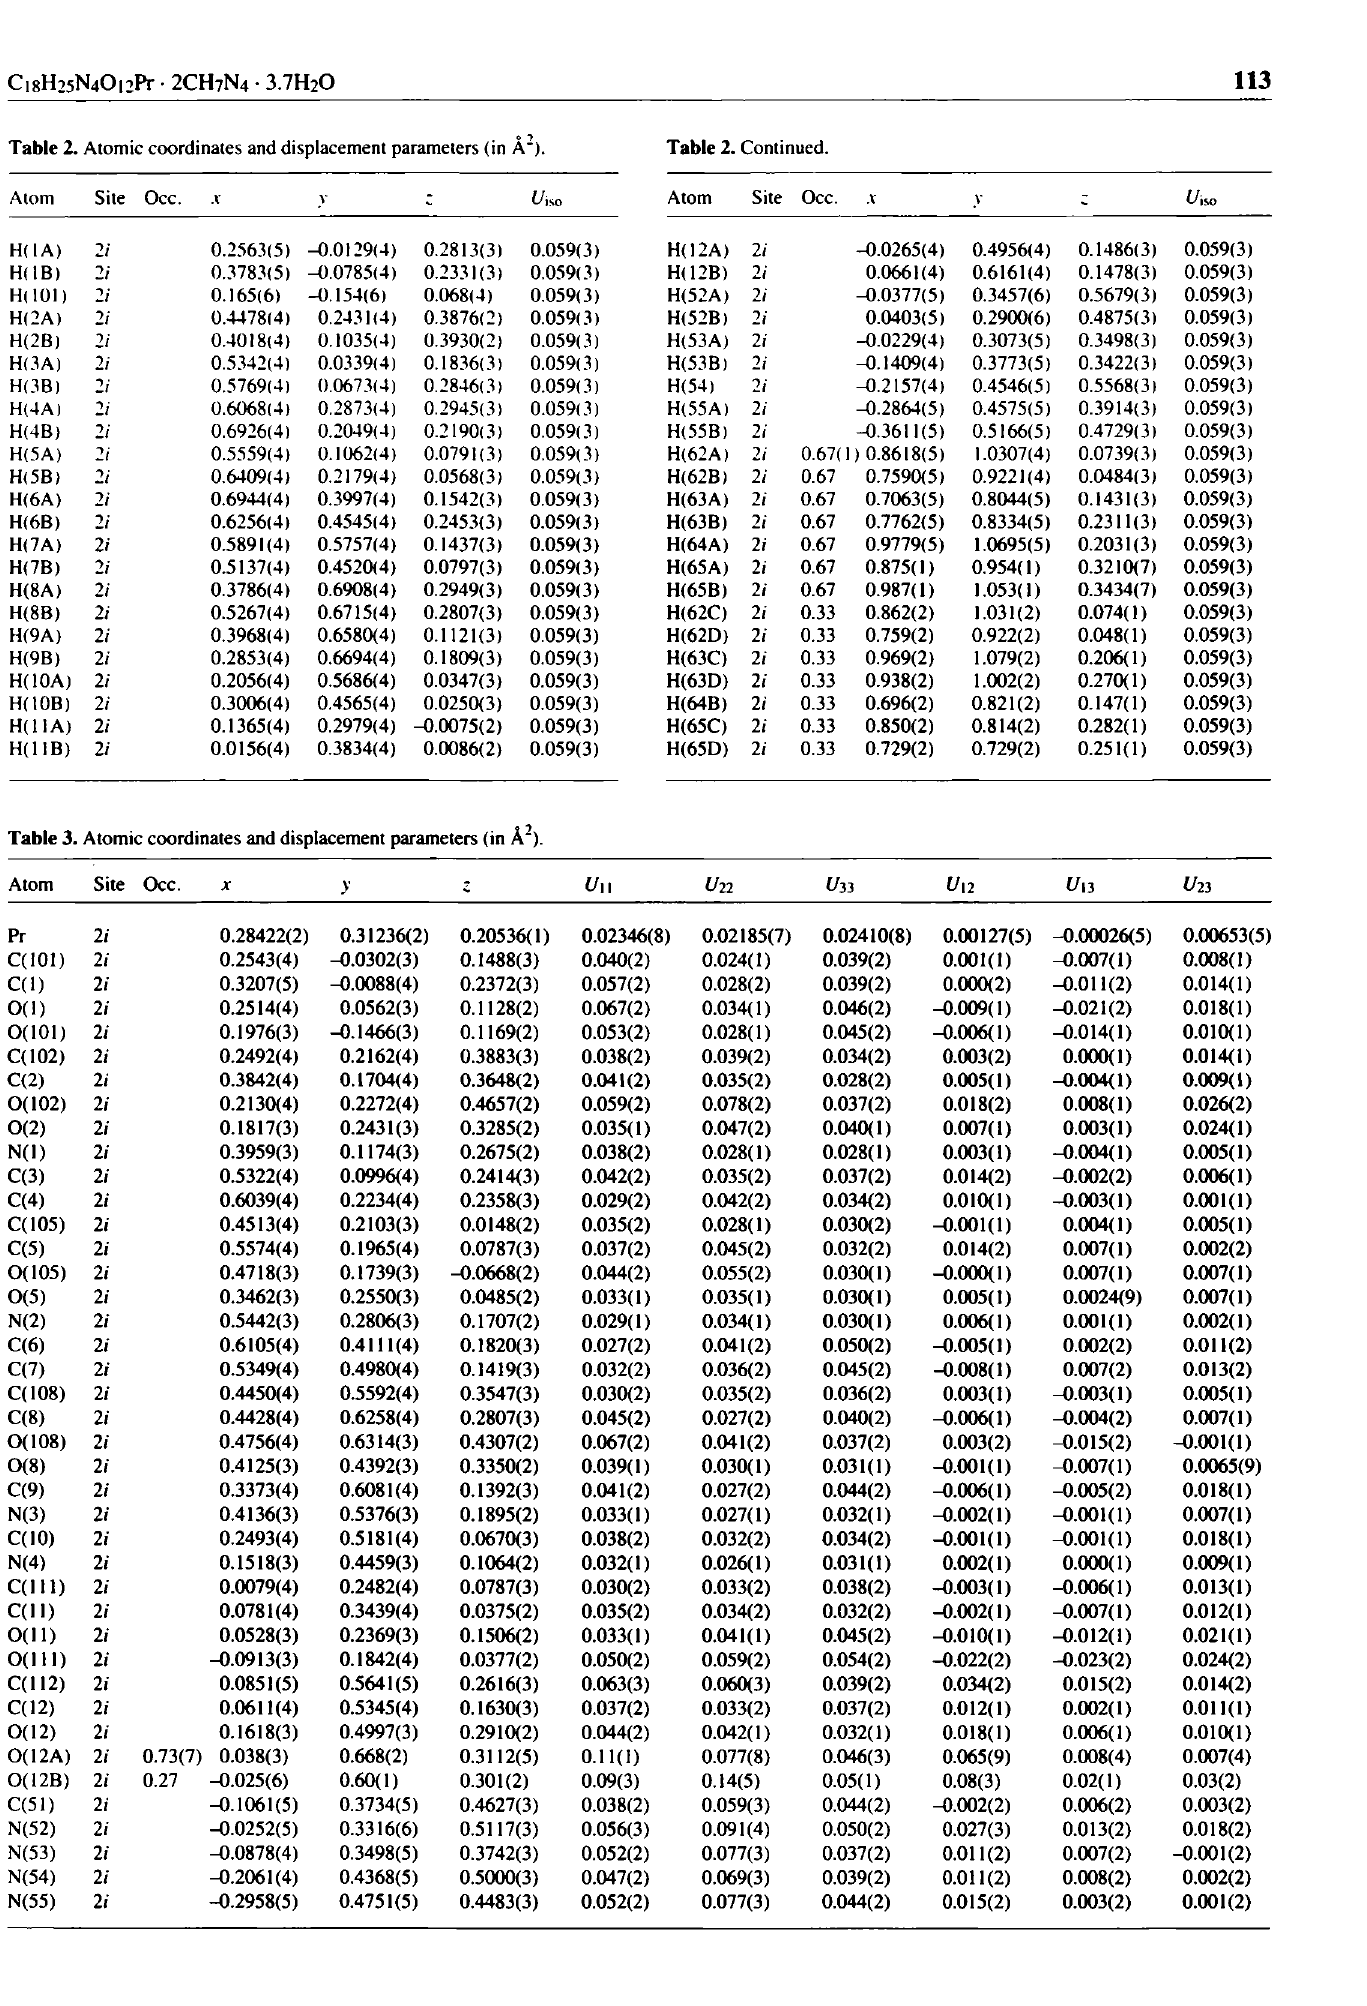
Table 3. Atomic coordinates and displacement parameters (in Â 2